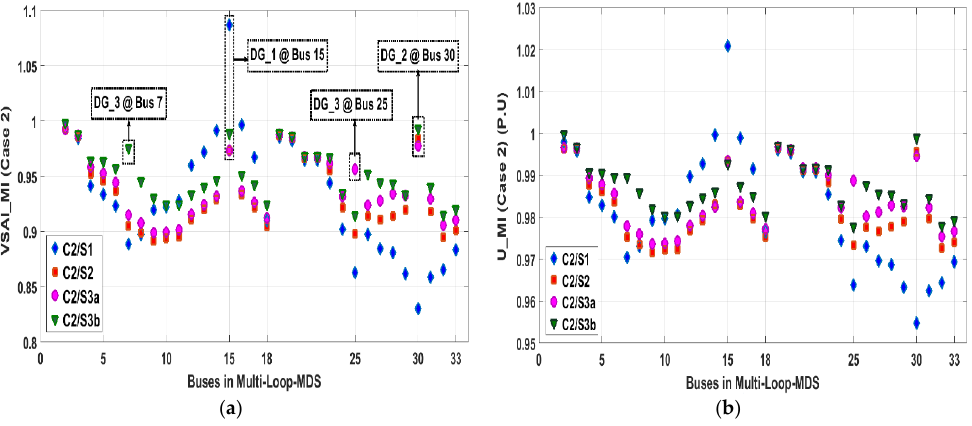
Figure 10. Case 2 for 33-bus MDS (L_Min) ( a ) VSAI trend (based on ideal MDS) for VSAI_MI-LMC; and ( b ) U-profile trend for VSAI_MI-LMC, based planning approach (DG operates @ pf = 0.85 ± 2.5%).